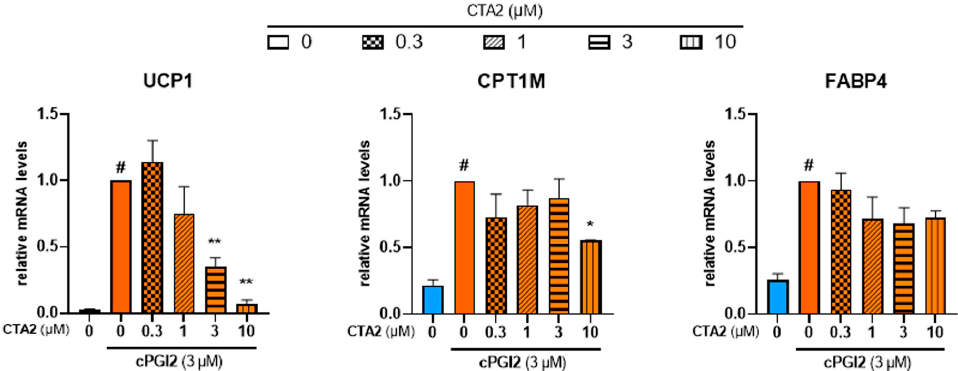
Figure 6. CTA2 limits cPGI2-induced browning process of white hMADS adipocytes. White hMADS adipocytes (blue columns) were induced to convert (from day 14 to day 18) into brite adipocytes (orange columns) in the presence of 3 µM cPGI2 and in absence or presence of various amounts of CTA2. mRNA levels of UCP1, FABP4 and CPT1M were measured. Histograms represent % of mRNA level relative to control condition (3 µM cPGI2) and display mean ± SEM of three to six independent experiments. Statistics were conducted through a one-way ANOVA with Dunett’s multiple comparisons test, where p < 0.05 was considered significant: #: p < 0.05, white vs. brite adipocyte, *: p < 0.05, **: p < 0.01, vs. 3 µM cPGI2 treated adipocytes. PGI2 and TXA2 exert their effects through membrane receptors PTGIR and TXA2R, respectively [44,45]. Both receptors are expressed in hMADS adipocytes (Figures 7A and 7B) and significantly reduced in the presence of 100 nM rosiglitazone. The addition of cPGI2 tends to reduce mRNA levels of PTGIR, mimicking the effects of rosiglitazone. To further study TXA2R’s role in CTA2 inhibitory effect, we used a specific receptor antagonist (L655,240) in the presence of rosiglitazone (Figure 7C) or cPGI2 (Figures 7D). The results showed that inhibition of UCP1 mRNA expression by CTA2 was partially re- versed in the presence of L655,240, suggesting the involvement of other pathways in CTA2 effects.